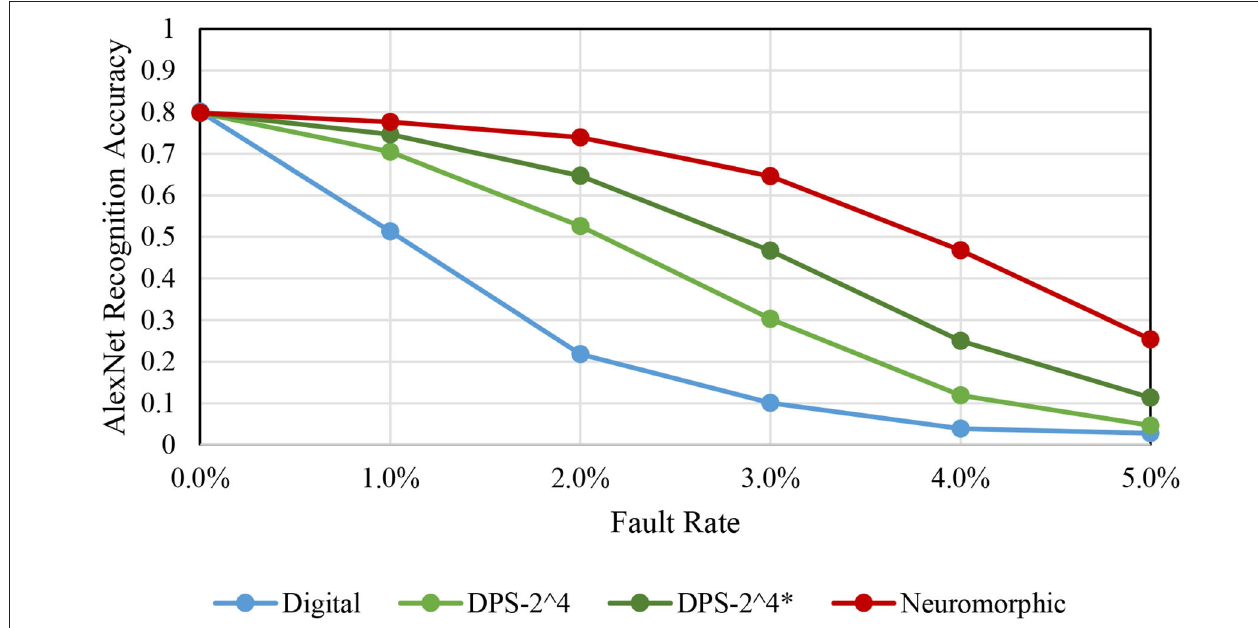
FIGURE 11 | Fault tolerance comparison among different schemes, for AlexNet.